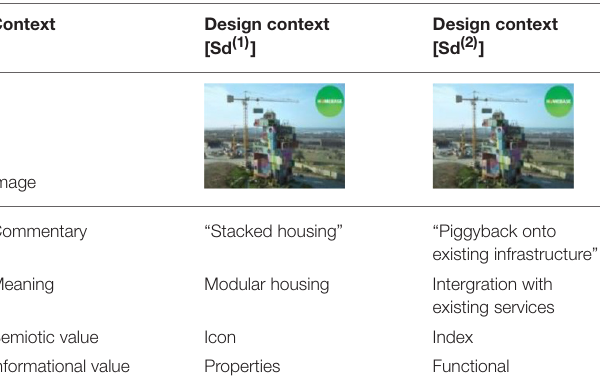
TABLE 2 | Example of a coded transition within the design context.